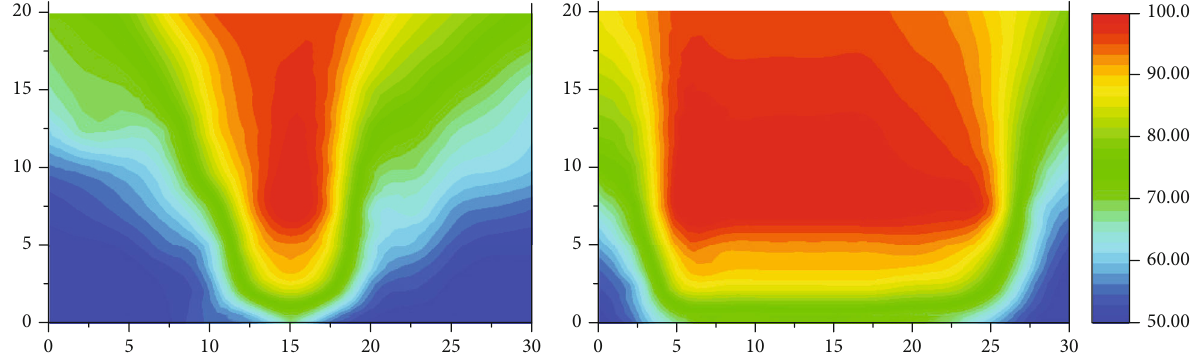
Figure 16: Temperature fi eld in the 3D model during the end stage of Experiment 3: (a) in the vertical direction of the wells and (b) along the wells.